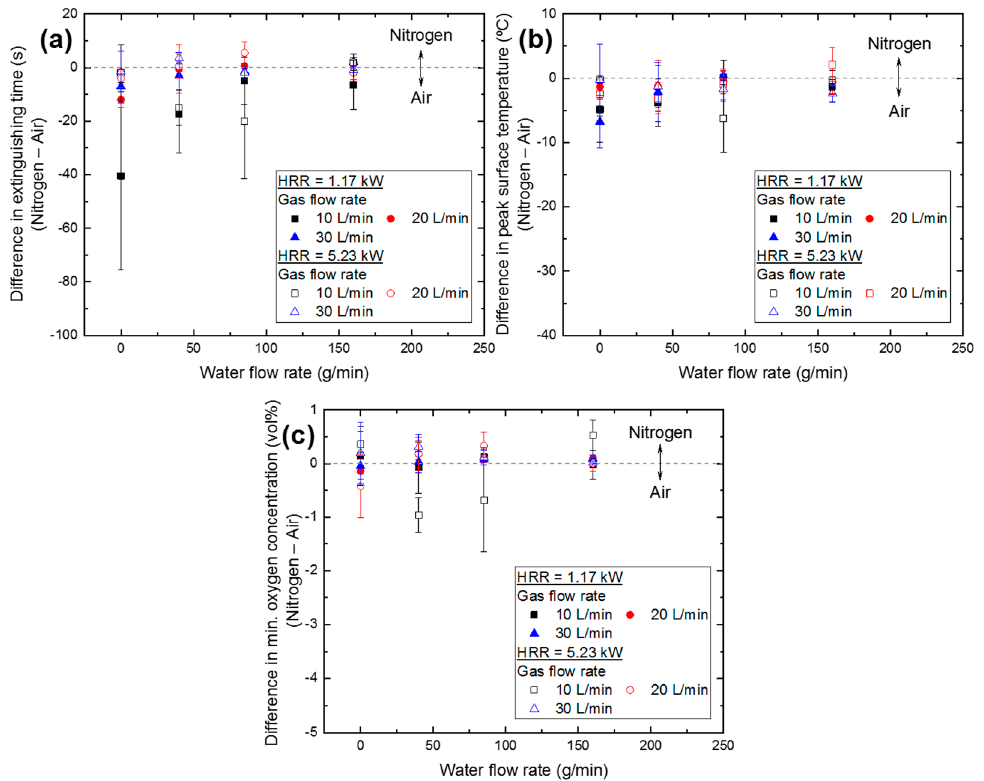
Figure 15. Comparison of differences in measurement parameters between nitrogen and air: ( a ) extinguishing time, ( b ) peak surface temperature, and ( c ) minimum oxygen concentration.